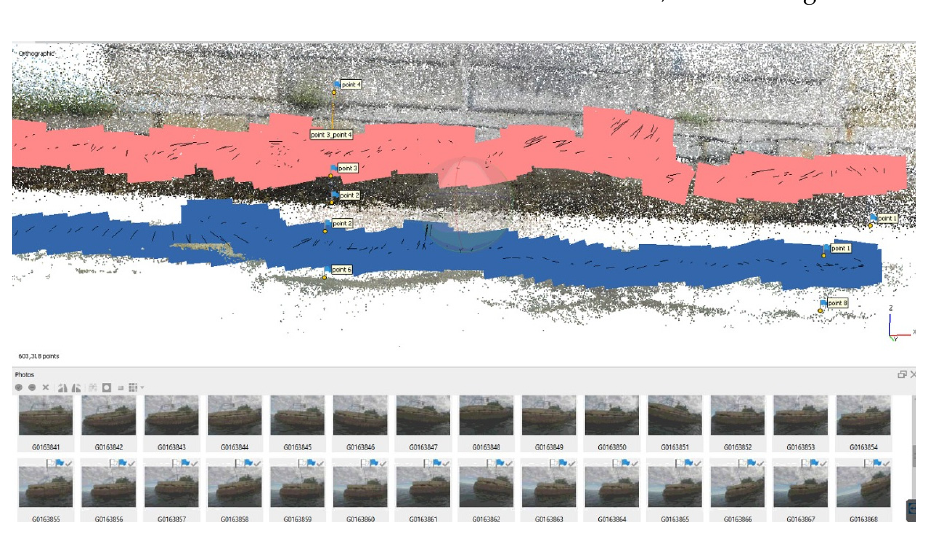
Figure 7. The acquisition points at site 1.